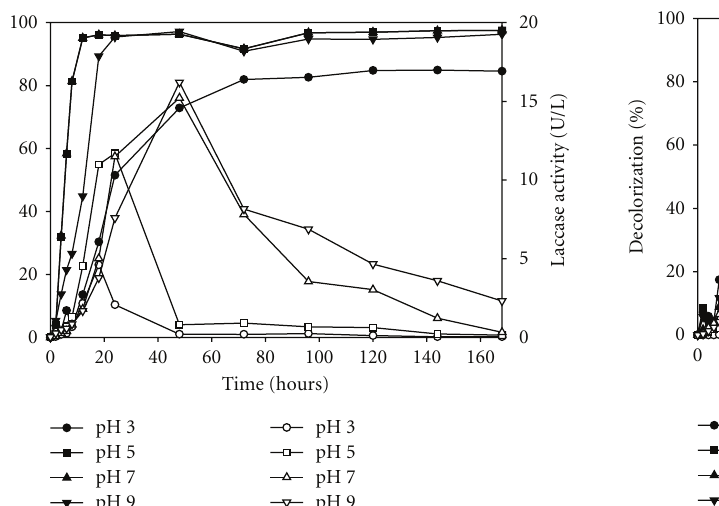
Figure 6: The e ff ect of pH on %decolorization of RB5 dye solution and Lac activity after cultivation with Datronia sp. KAPI0039; close symbol = %decolorization; open symbol = Laccase